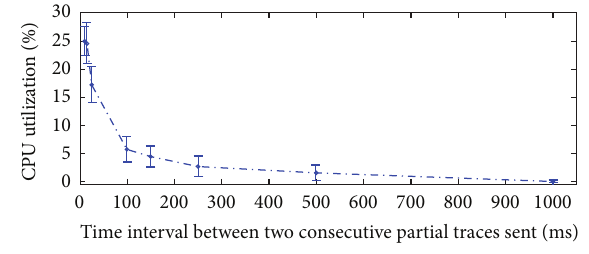
Figure 9: CPU utilization of the Sink.